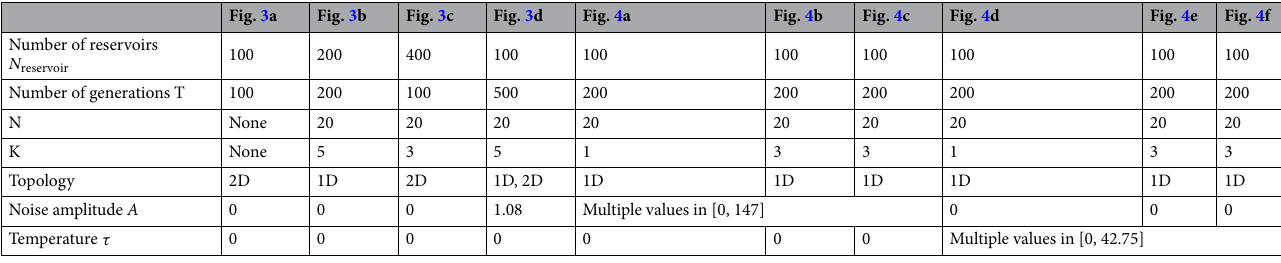
Table 3. Parameters that are